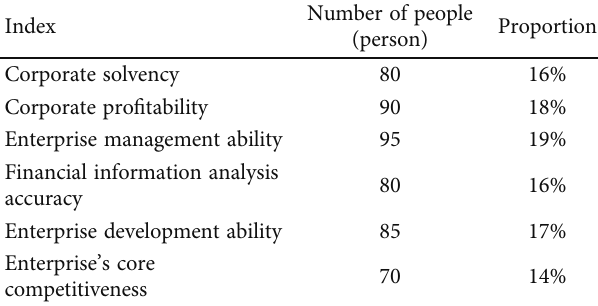
Table 1: Questionnaire survey result